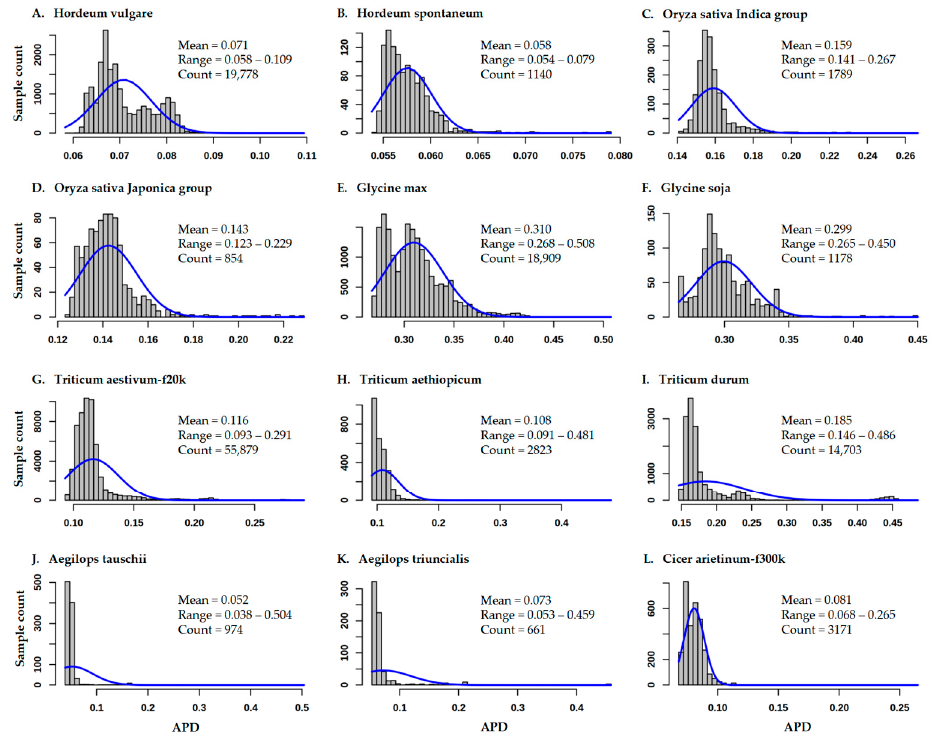
Figure 1. Distributions of APD estimates for all the samples in 12 germplasm APD data sets ( A – L ).